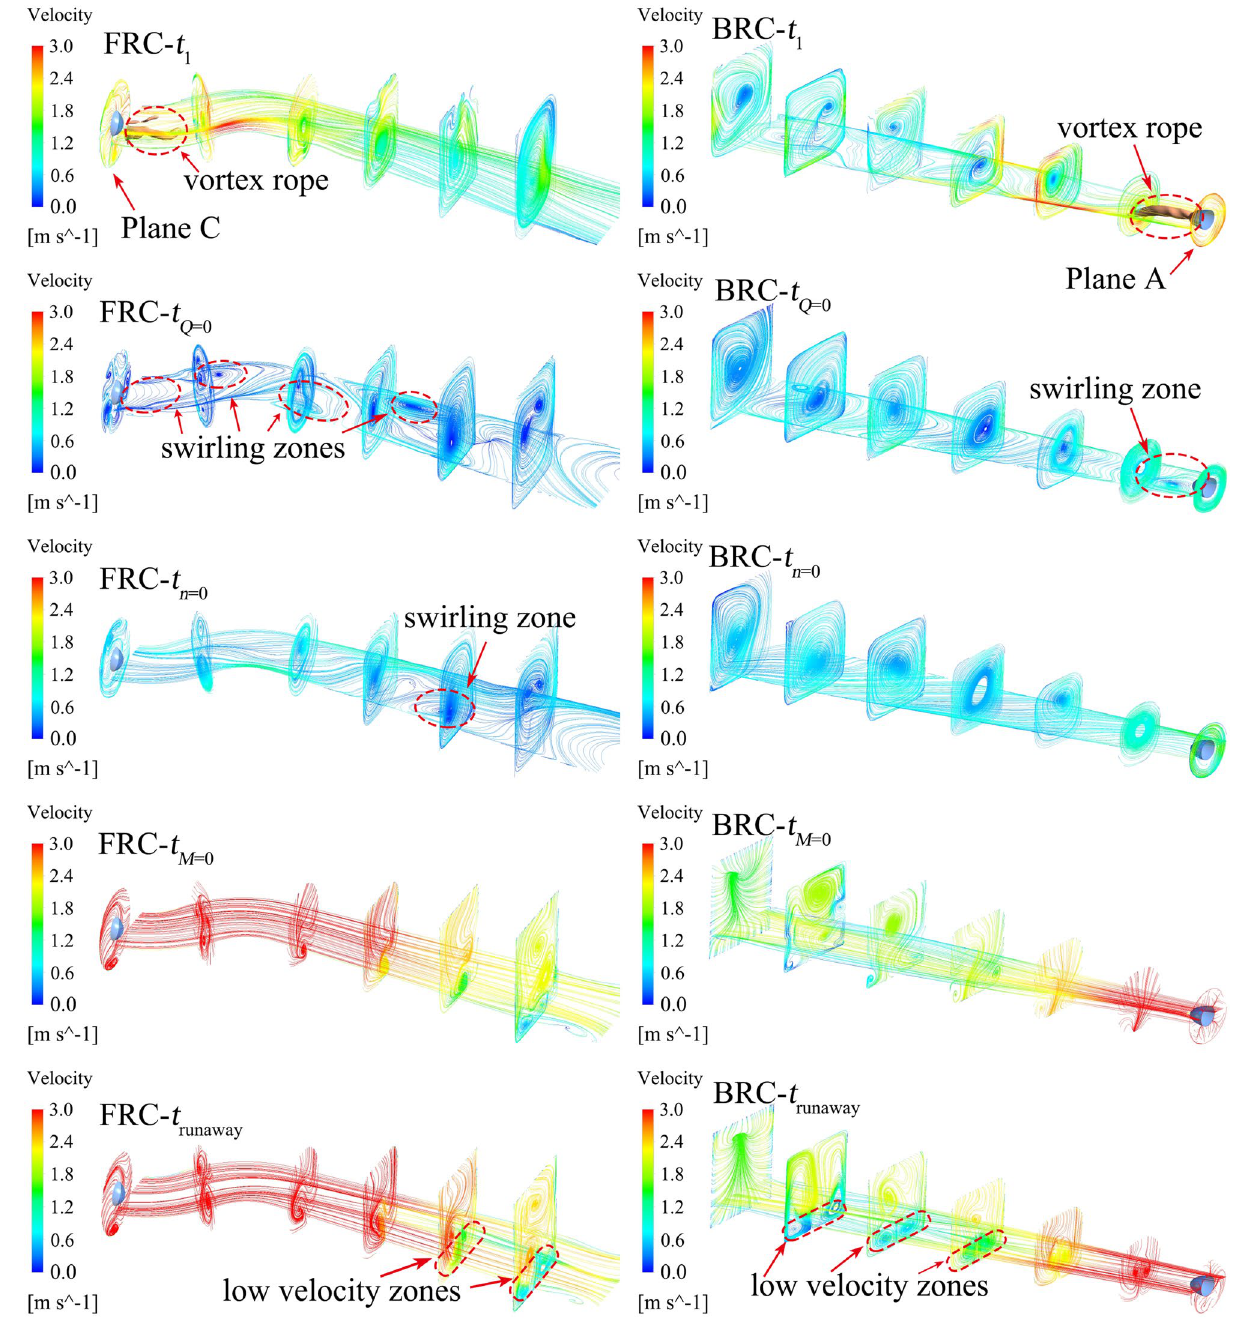
Figure 18. Streamline and vortex core distribution of outlet conduit under FRC and